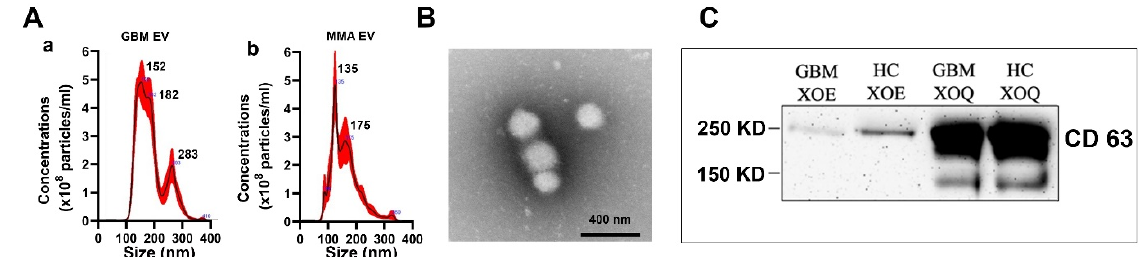
Figure 1. Characterization of EVs derived from plasma of patients with brain tumors. Plasma EVs were purified using ExoEasy and ExoQuick kits. ( A ) Nanoparticle Tracking Analysis showing ex- amples of typical size and concentrations of the plasma EVs of GBM ( a ) and MMA ( b ) by ExoEasy. ( B ) Transmission electron microscope image showing ExoEasy purified GBM EVs, which are 100–200 nm diameters in size. ( C ) Western blots run on Native conditions demonstrated the presence of EV marker CD63 in GBM and HC plasma EVs. EVs were purified from plasma with ExoEasy (XOE) and ExoQuick (XOQ) followed by electrophoresis in Native gel. The blot was detected with mouse anti-human CD63 (1:1000). The CD63 proteins showed a much large size at 250 KD due to heavy glycosylation under native conditions, rather than the 25 KD under denaturing conditions. We found that CD63 protein was more abundant in Exo-Quick-purified EVs than in Exo-Easy-purified EVs.